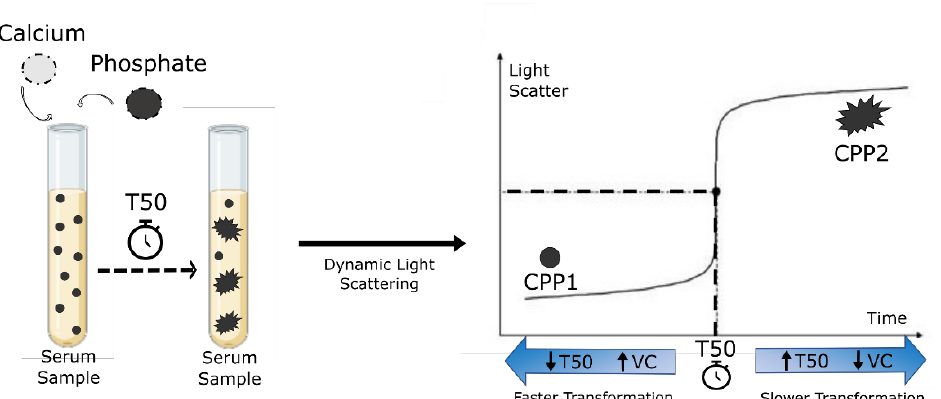
Figure 3. Calciprotein particle in vitro blood tests. ( A ) The CPP/Fetuin-A test measures the CPP concentration through a ratio between total Fetuin-A and non-sedimented Fetuin-A after centrifu- gation of serum samples. ( B ) The T50 test is a method that involves the mixing of patient serum with buffered solutions of calcium and phosphate and subsequent monitoring of changes in light scatter- ing to determine the half time of transition (T50) from primary to secondary CPP in serum.